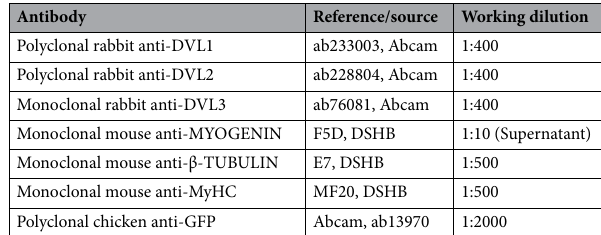
Monoclonal mouse anti-β-TUBULIN